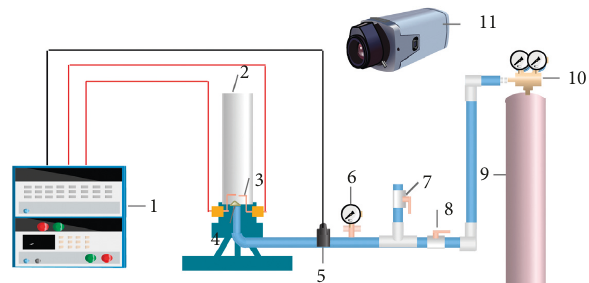
Figure 2: Dust MIE experimental device. (1) Ignition energy production system; (2) 1.2L glass tube; (3) ignition lead; (4) nozzle, high-pressure air cylinder; (5) powder storage bin; (6) pressure gauge; (7) exhaust valve; (8) air inlet valve; (9) high-pressure air cylinder; (10) pressure relief valve; (11) high-speed